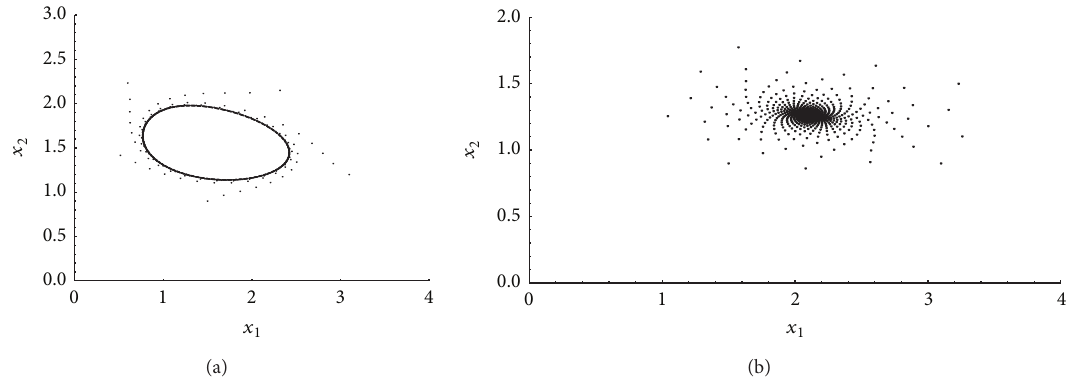
Figure 3: (a) An invariant curve generated by (1) and (2). Parameter values 𝜇 1 = 𝜇 2 = 0.5 , 𝐹 = 20 , and ℎ 1 = ℎ 2 = 0 . (b) An attracting fixed point. Parameter values as in (a) but ℎ 2 = 0.25